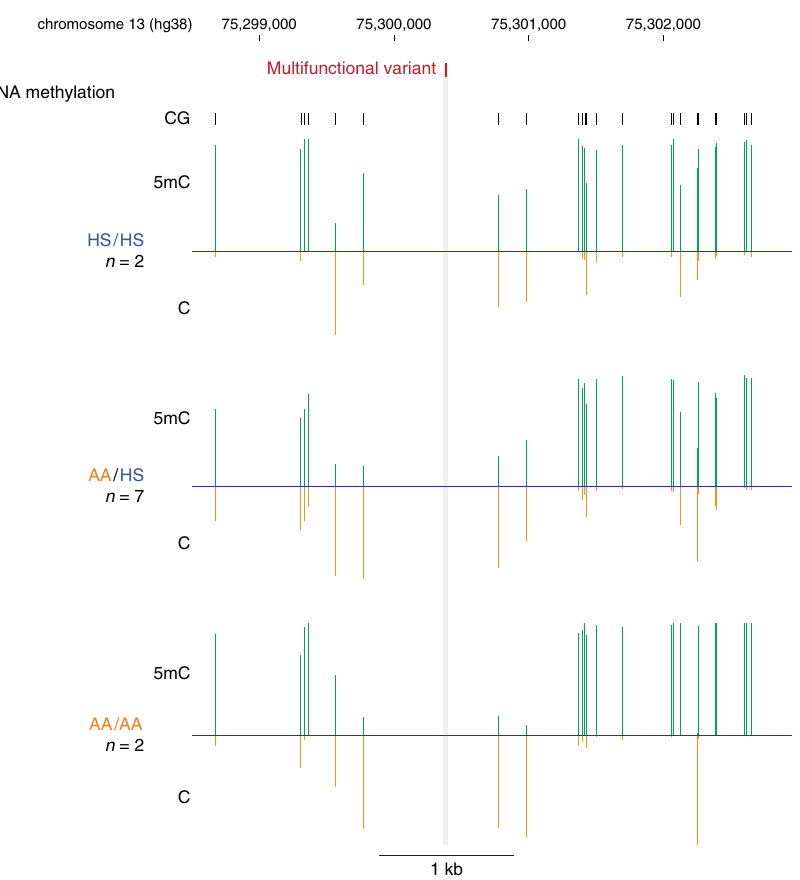
Fig. 8 DNA methylation in the 5 kb context of the TBC1D4 multifunctional variant. We show the DNA methylation (5mC) for each cytosine in green with the corresponding unmethylated (C) fraction of alleles in orange, so that loci found to have very low levels of DNA methylation do not appear to be missing in the representation. We show the mean values for the 2 HS/HS, 7 AA/HS, and 2 AA/AA individuals. There are no cytosines suf fi ciently close to the multifunctional variants to allow observation of haplotypic patterns of DNA methylation, but there is a pattern of less DNA methylation at loci closest to the multifunctional variant in individuals with the AA haplotype. 5mC values, along with median coverage, are provided in a Source Data fi